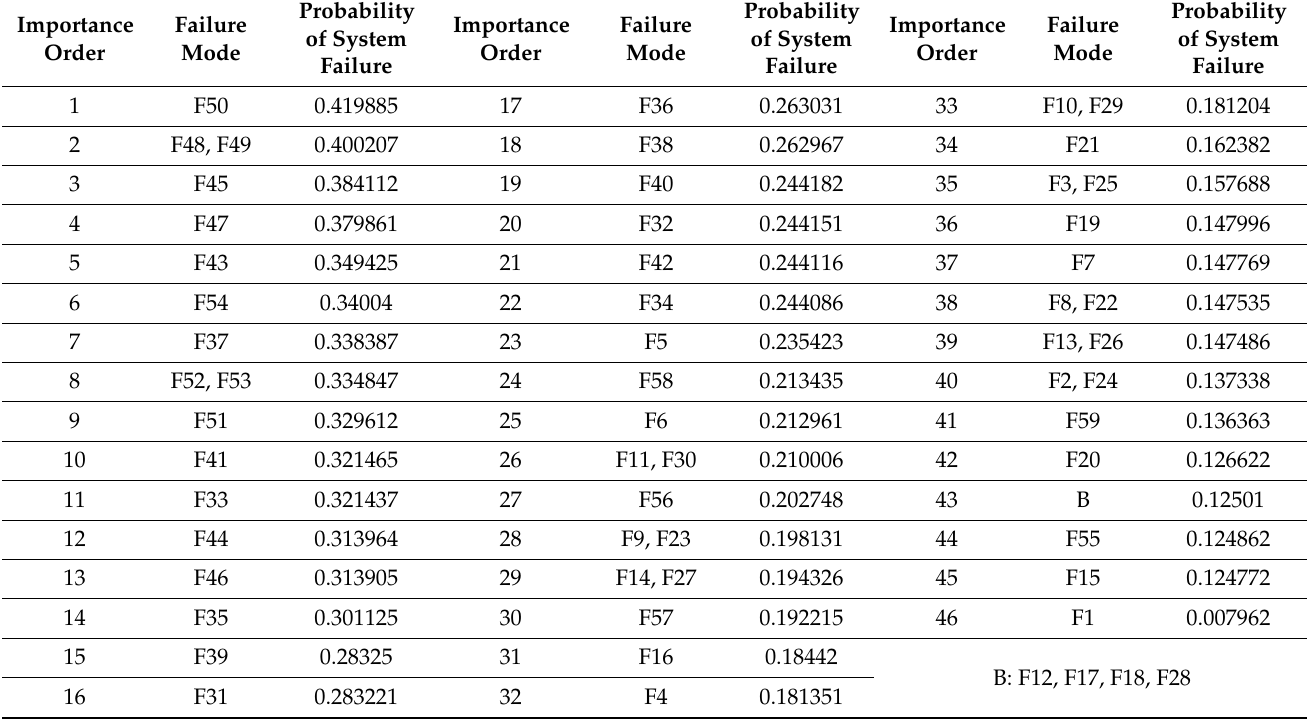
Table 6. Failure mode importance ranking